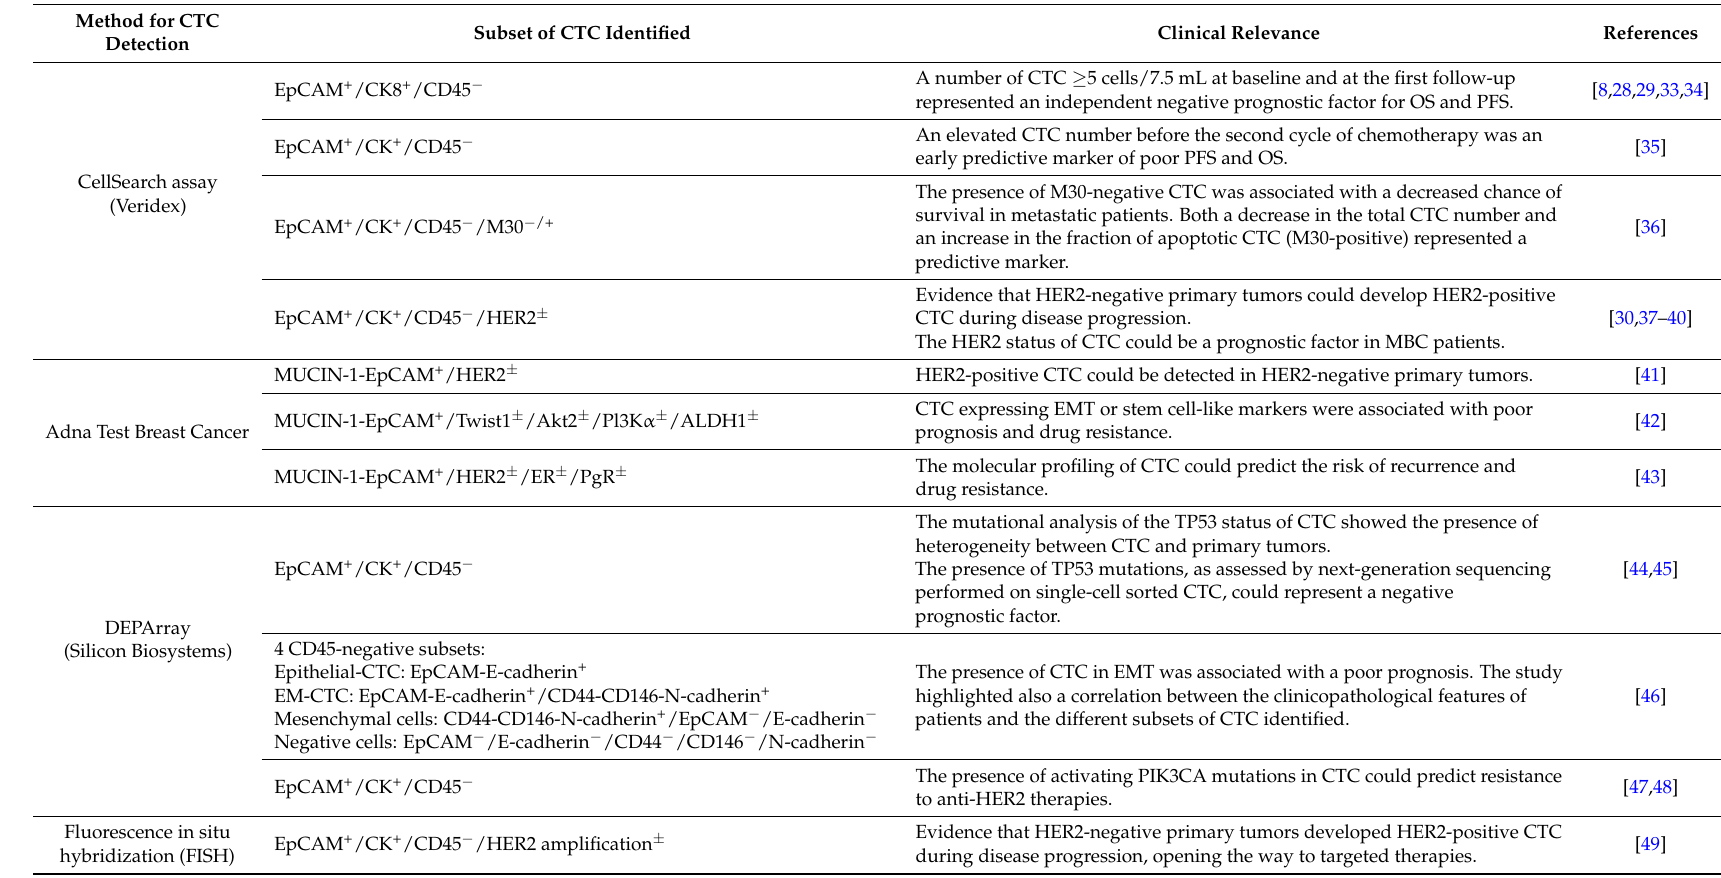
Table 1. Clinical relevance of specific CTC (circulating tumor cell)